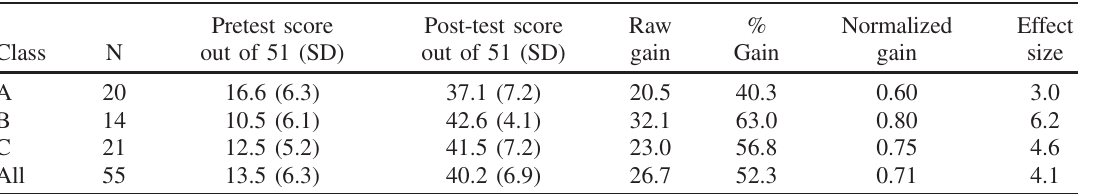
TABLE III. Comparison of mean scores between pretest and post-test (Fall 2014).